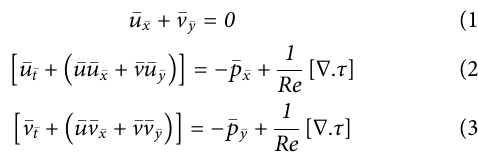
Frontiers in Physics |